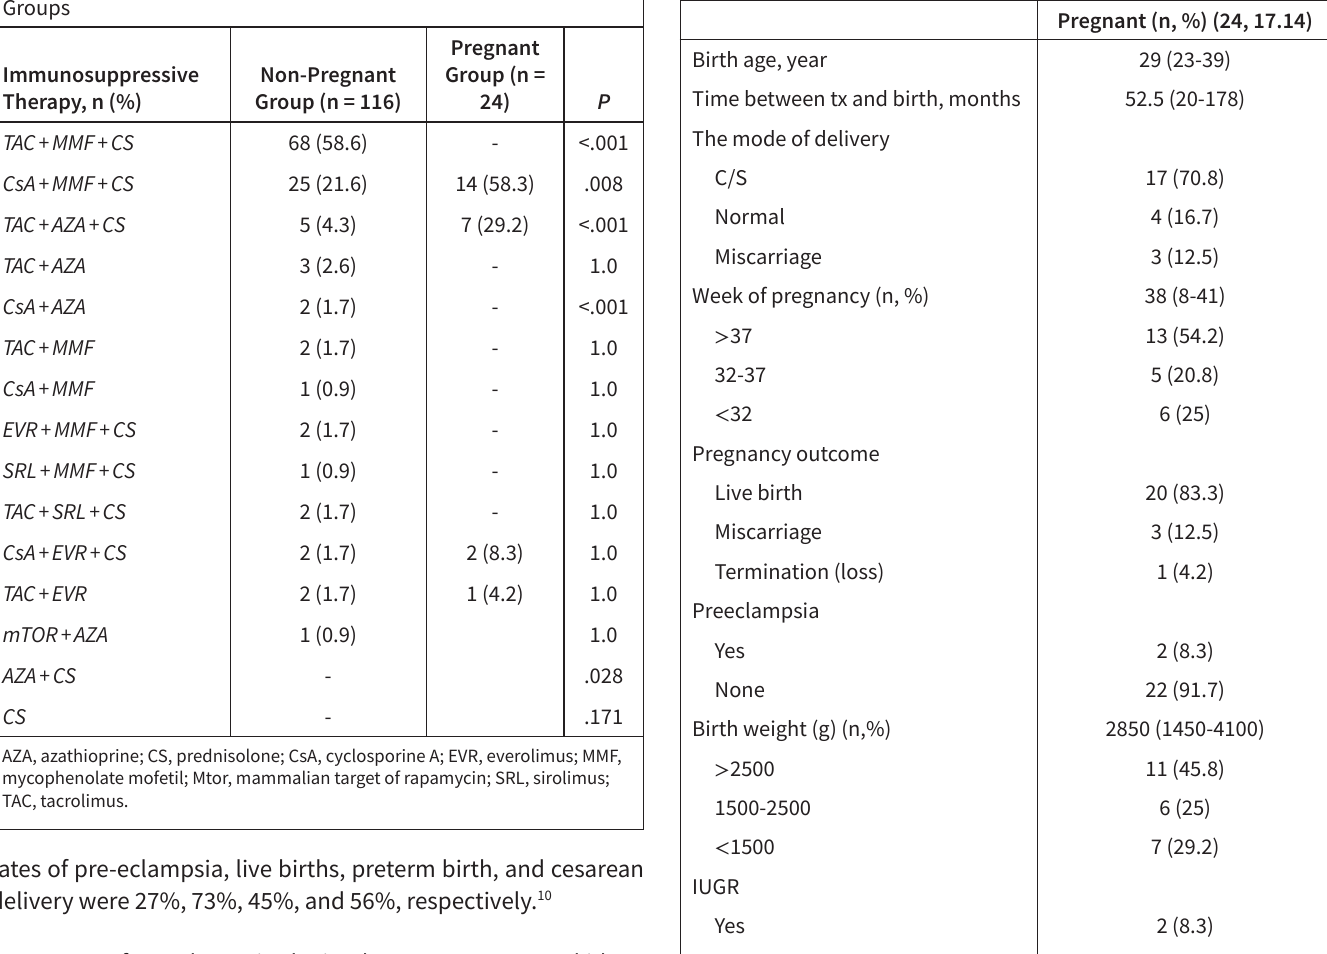
Table 3. Comparison of Immunosuppressive Therapy Between the Table 4. Characteristics of Pregnant Women and